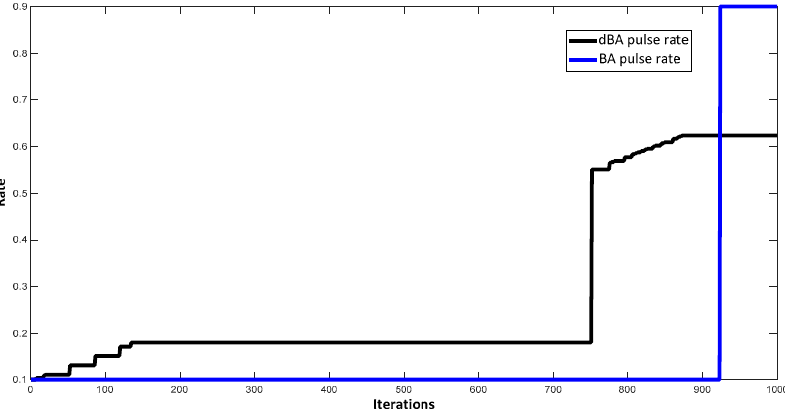
Figure 8. The pulse rate of the best bat of the BA and dBA.